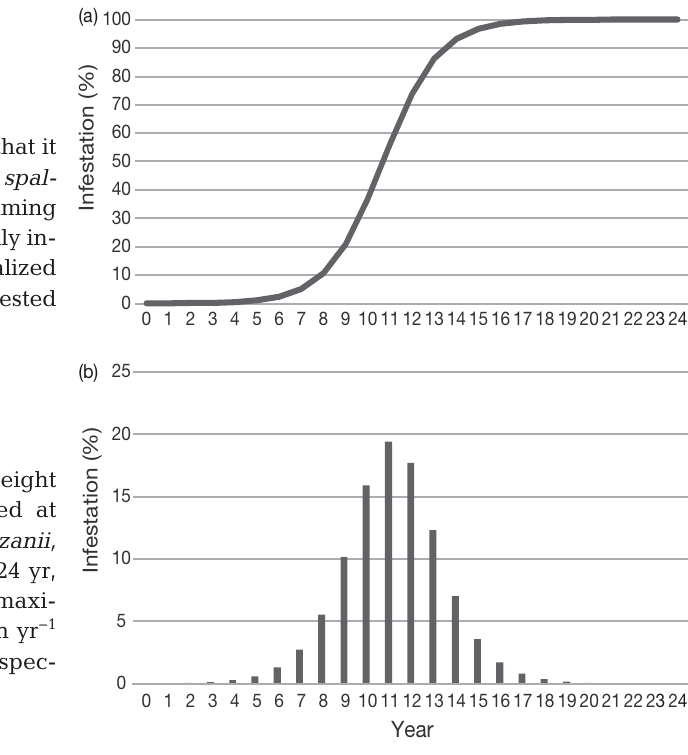
Fig. 2. (a) Cumulative percentage of invaded green-lipped mussel farms per year and (b) absolute percentage of mussel farms invaded by Styela clava and Sabella spallanzanii per